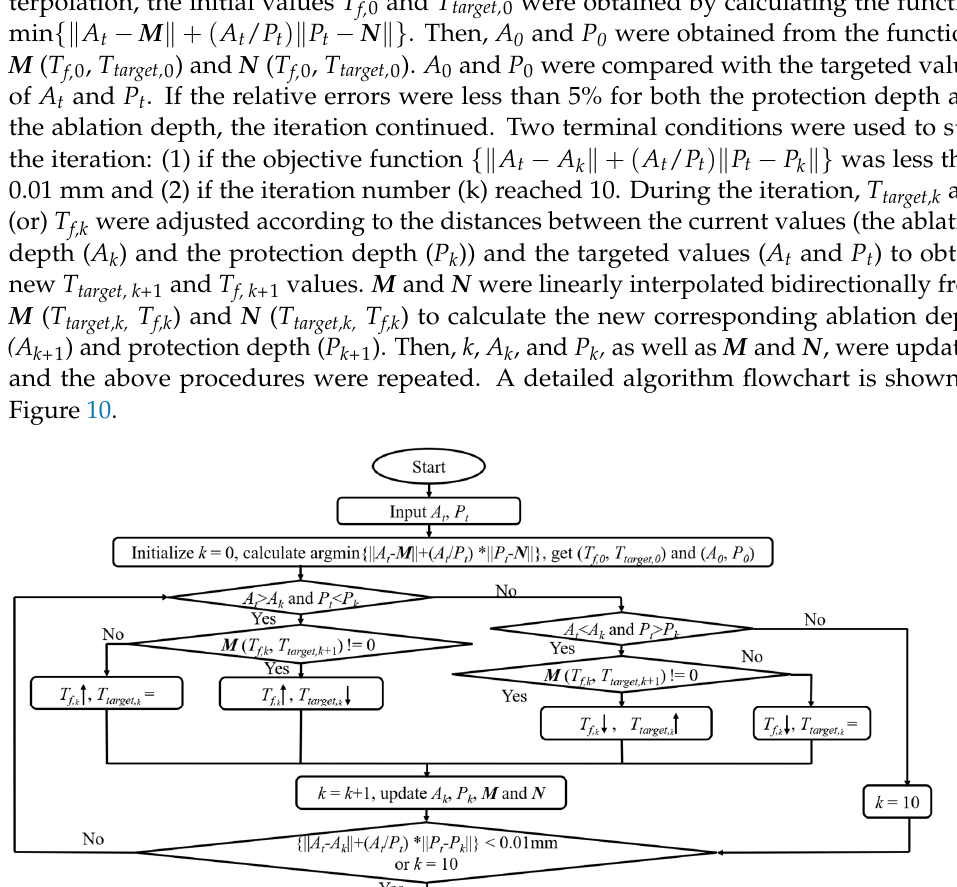
Figure 11. ( a ). Case 1: the objective ablation parameters were A = 0.78 mm and P = 0.06 mm; ( b ). Case 2: A =1.02 mm and P =0.1 mm. The real ablation parameters are marked with arrows. 4. Discussion Based on the experimental study, it was found that the temperatures at the three monitoring points (T1, T2, and T3) inside the tissue, representing the locations of plaque, adventitia, and surrounding tissue [28], changed linearly with the three control parame- ters. Moreover, the two parameters T target and T f were found to be the main factors that adjusted the ablation results, including the ablation depth and protection depth.